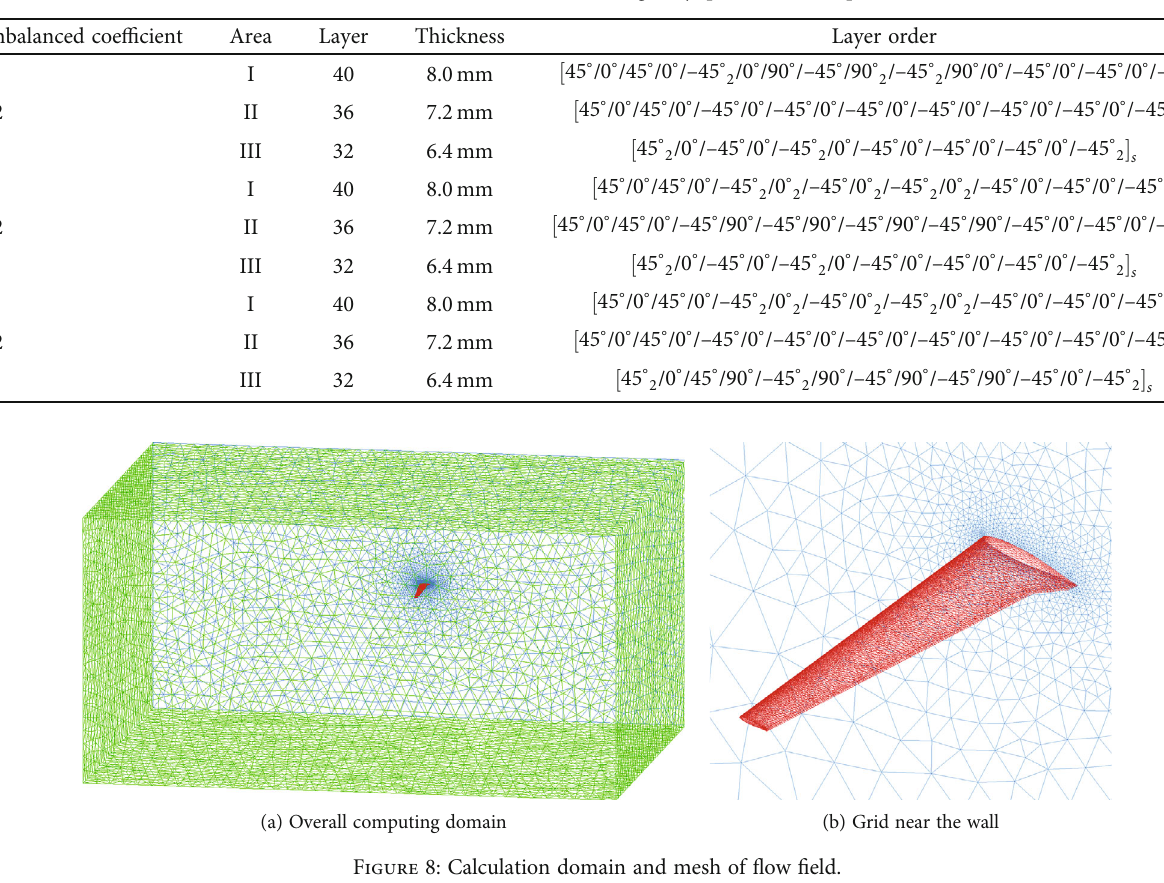
Table 6: Variable thickness and angle layup scheme example.